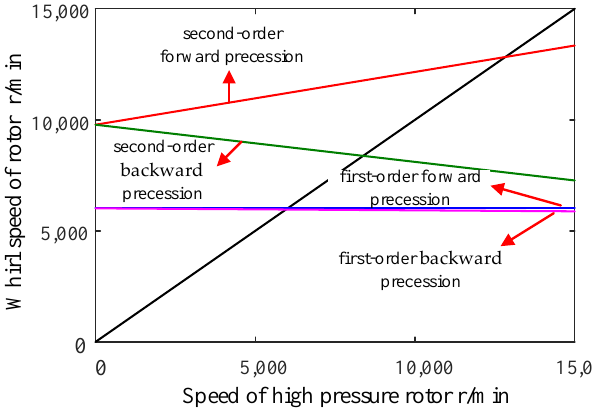
Figure 4. Mode of high-pressure rotor: ( a ) first order, ( b ) second order. Calculating the modal frequency at different speeds from 0 to 15,000 rpm, the Campbell diagram of the high-pressure rotor is obtained in Figure 5. The intersection point of the line with slope 1 and other curves is the critical speed of the high-pressure rotor in reverse precession and forward precession, respectively.